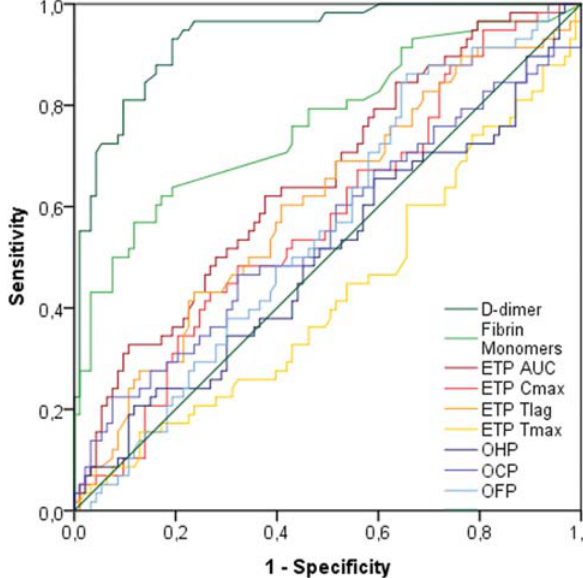
Fig. 4 Receiver-operating characteristic (ROC) curves for global hemo- static assays, D-dimer, and fi brin monomers. D-dimerand fi brin monomers areplottedingreen,overallhemostaticpotential(OHP)parametersinblue, and endogenous thrombin potential (ETP) parameters in red-orange. ETP T max (light orange) is negative because it is the only parameter where a smaller test result indicates a more “ positive ”